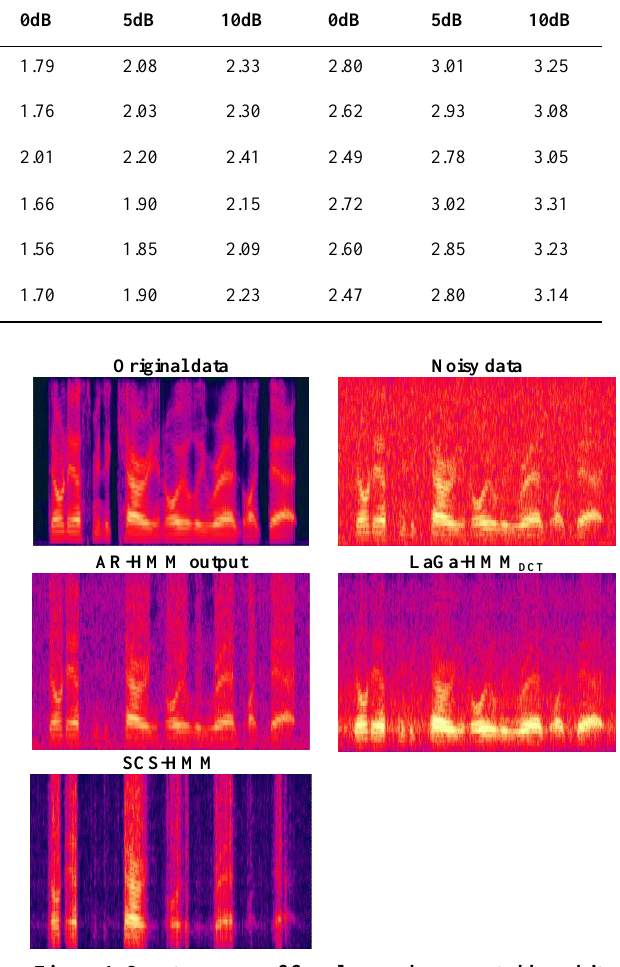
Figure 1. Spectrograms of female speech corrupted by white noise at SNR=5